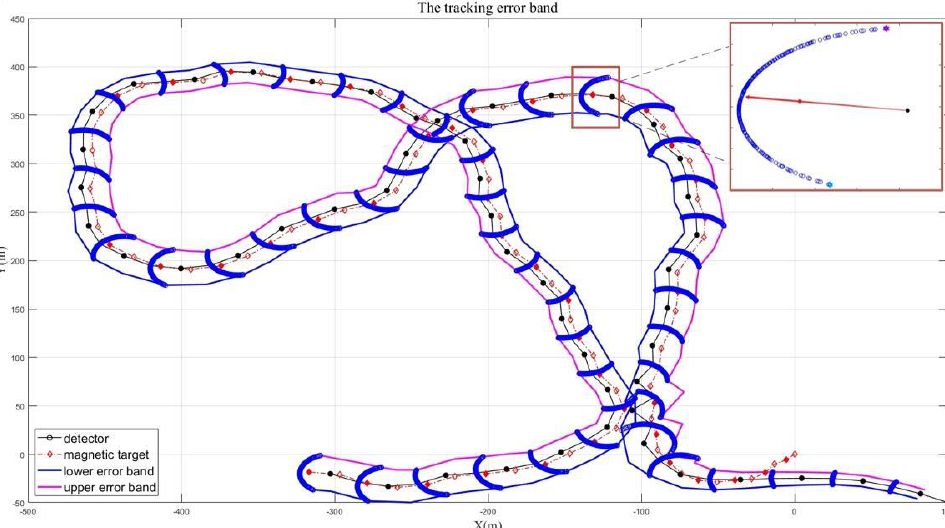
Figure 2. The tracking error band of a single moving target based on the equivalent magnetic force, in which a certain point in the tracking process is partially enlarged to explain the drawing